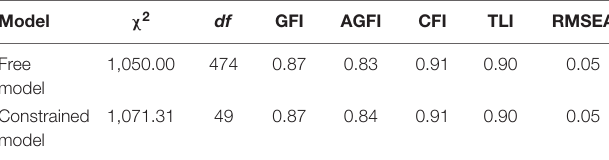
TABLE 6 | Comparison of measurement invariance test between the free and constrained